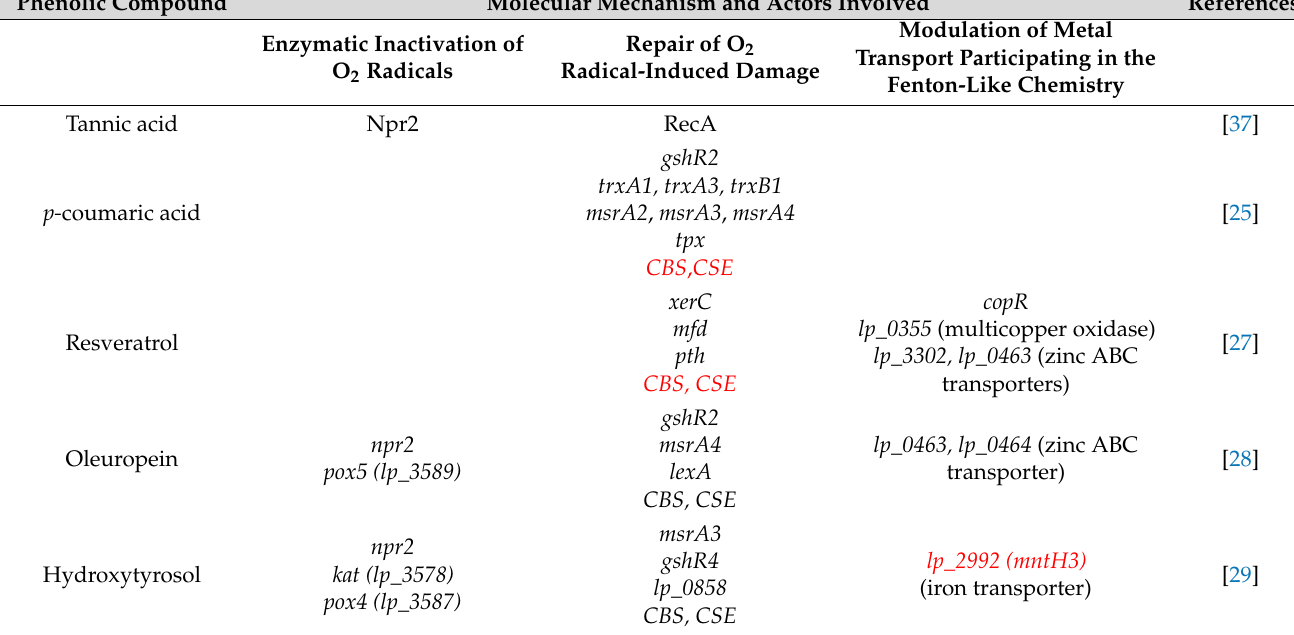
Black font: upregulated genes or proteins. Red font: downregulated